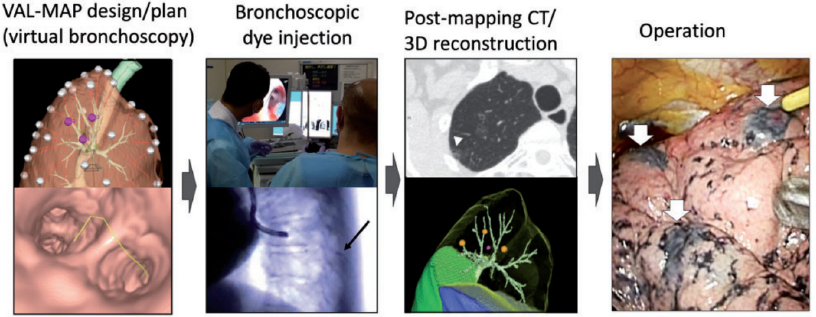
Figure 1. Steps of conventional virtual-assisted lung mapping [11].